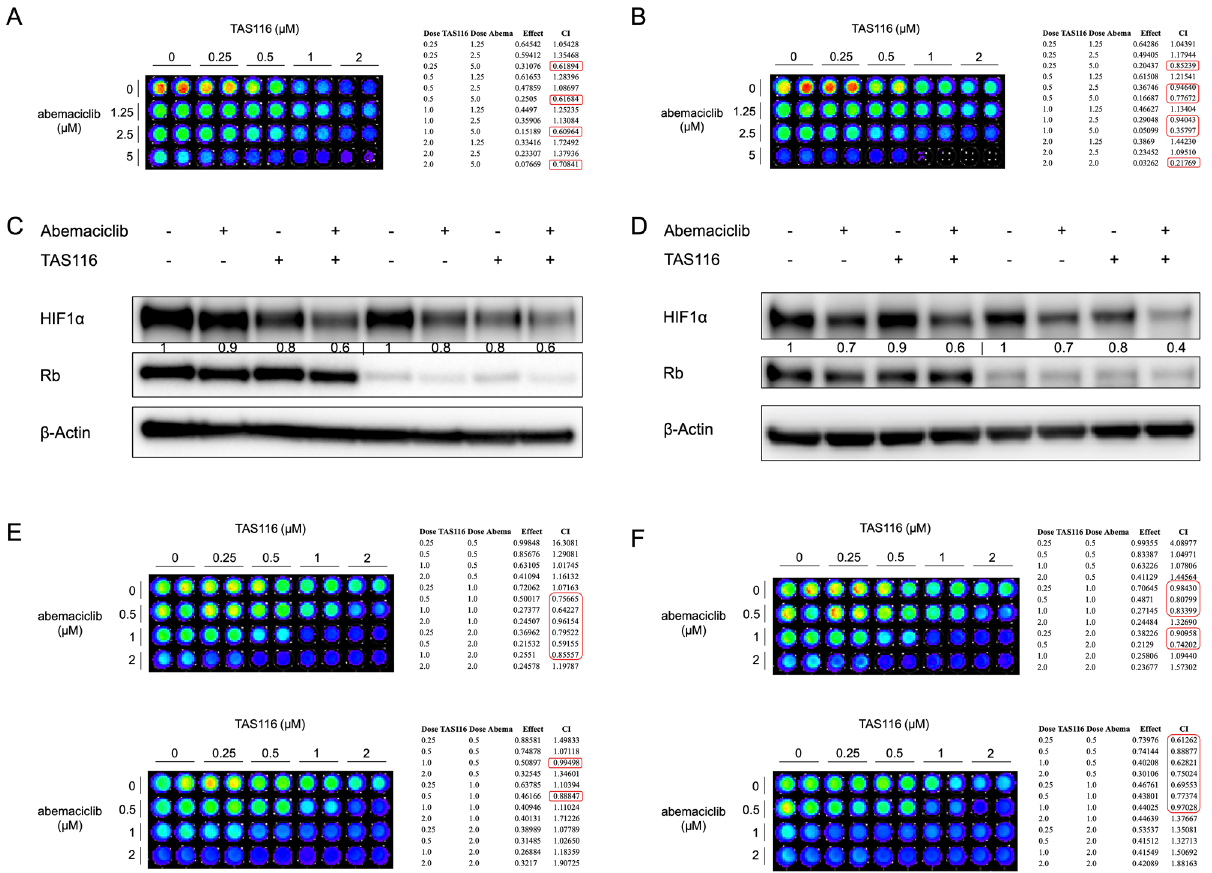
Figure 7. Rb -deficiency does not affect the combinatorial inhibition of HIF1α expression and cell viability. ( A , B ) Combination treatment with abemaciclib and TAS116 synergistically inhibits cell viability in Saos2 osteosarcoma cells at 72 h under ( A ) normoxia and ( B ) hypoxia (0.5% O 2 ). ( C ) SW480 cells were incubated with Rb -targeting siRNA for 48 h and subsequently treated with 1 μM abemaciclib and/or 0.5 μM TAS116 for 6 h in hypoxia (0.5% O 2 ). ( D ) Knockdown of Rb does not affect HIF1α inhibition by combination drug treatment with TAS116 and abemaciclib in MCF7 breast cancer cells. ( E , F ) SW480 cells were treated with ( E ) mock or ( F ) Rb-targeting siRNA for 48 h and subsequently treated with indicated combinations under normoxia (upper) or 0.5% O 2 hypoxia (lower).